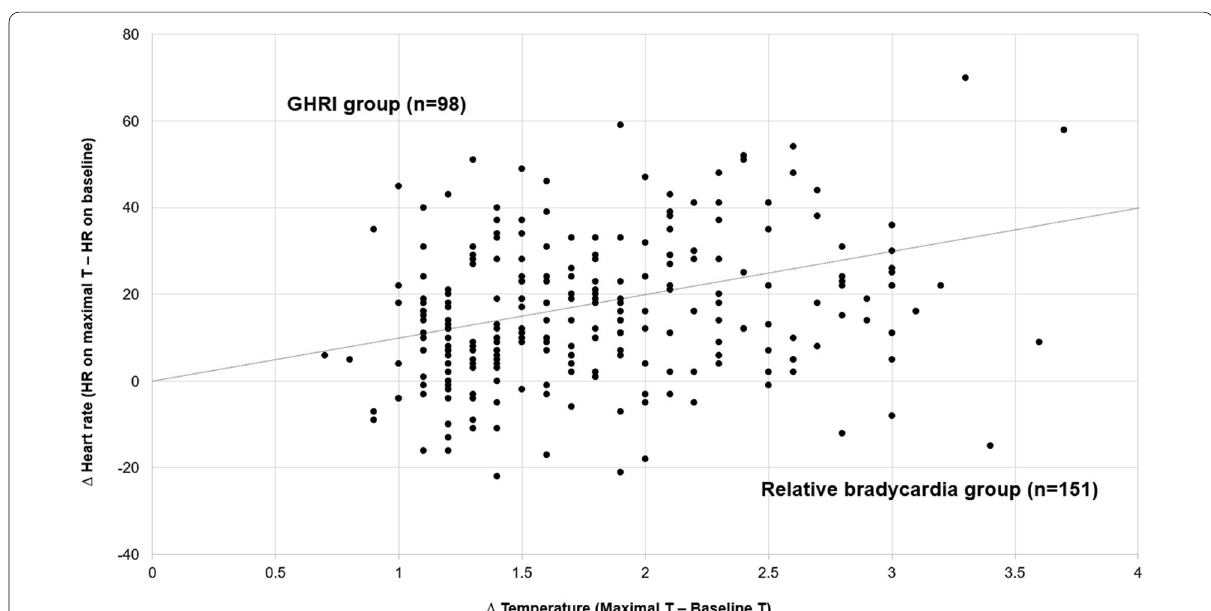
Fig. 1 Distribution of Δheart rate/Δtemperature by